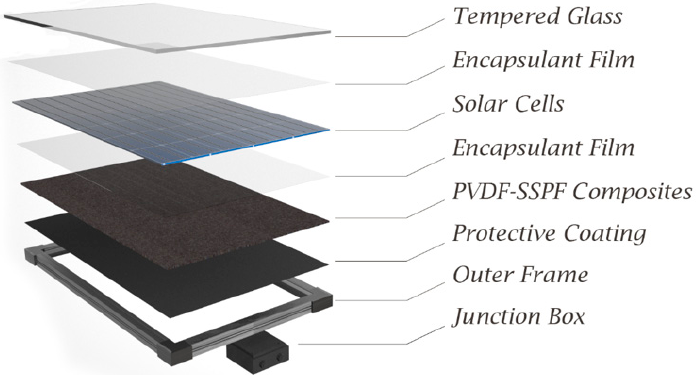
Figure 1. A schematic diagram of the proposed solar module including utilized components and functional parts.